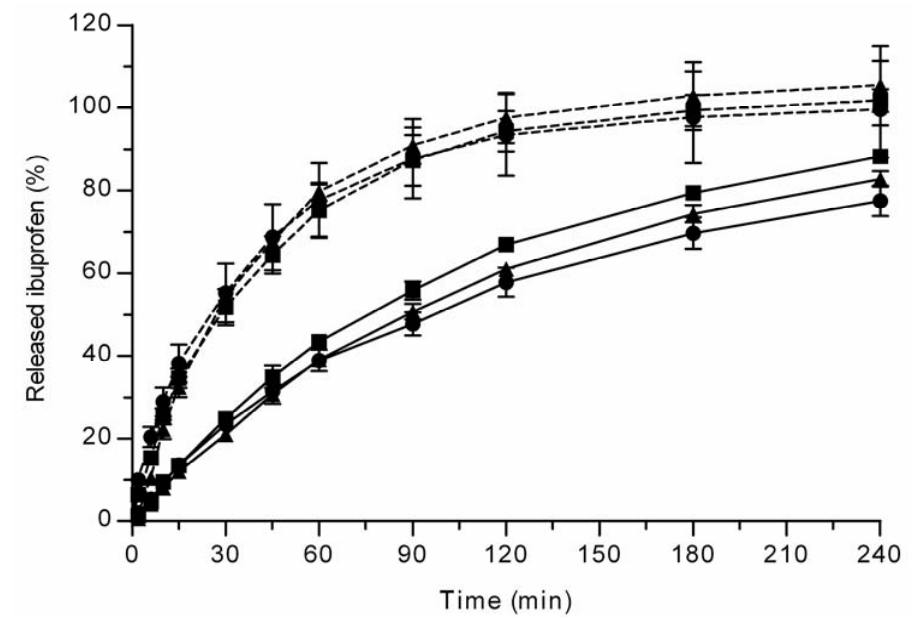
Figure 3. Ibuprofen release from TCPSi microparticles ( ● ), or the transport of ibuprofen applied either as a powder ( ▲ ) or a solution ( ■ ) into the acceptor chamber across the polyester (solid line) or polycarbonate (dashed line) membranes using the well-plate method. Mean ± SD values are shown (n =